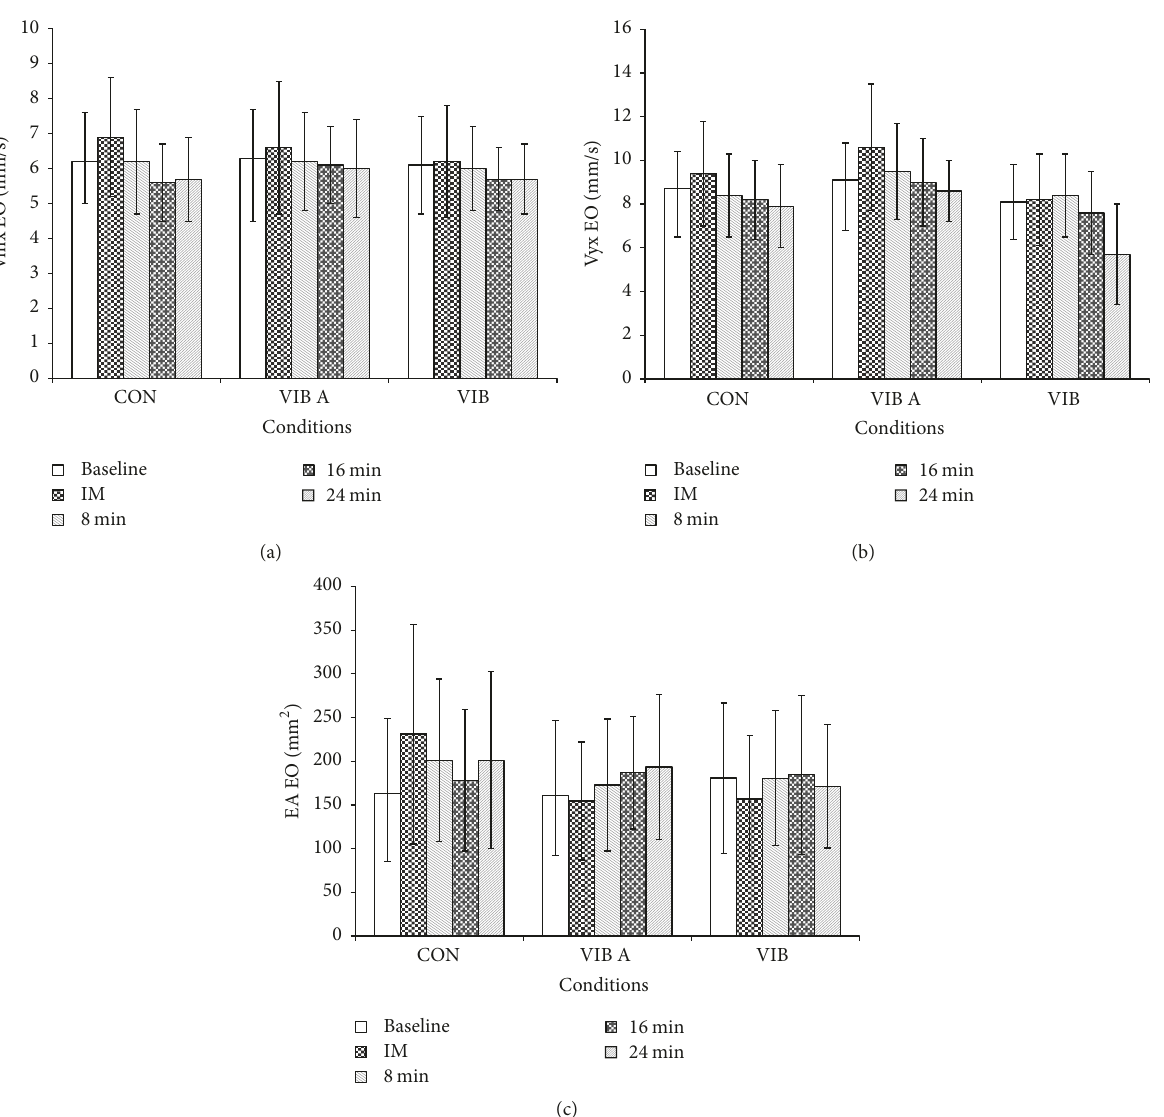
Figure 1: Mean values at baseline, immediately (IM) after the vibratory stimulus, and 8, 16, and 24 minutes after the vibratory stimulus. Mean velocity measures in the (a) medial-lateral direction (VMx; mm/s); (b) anterior-posterior direction (VMy; mm/s); and (c) elliptical area (EA; mm 2 ), during eyes open (EO)